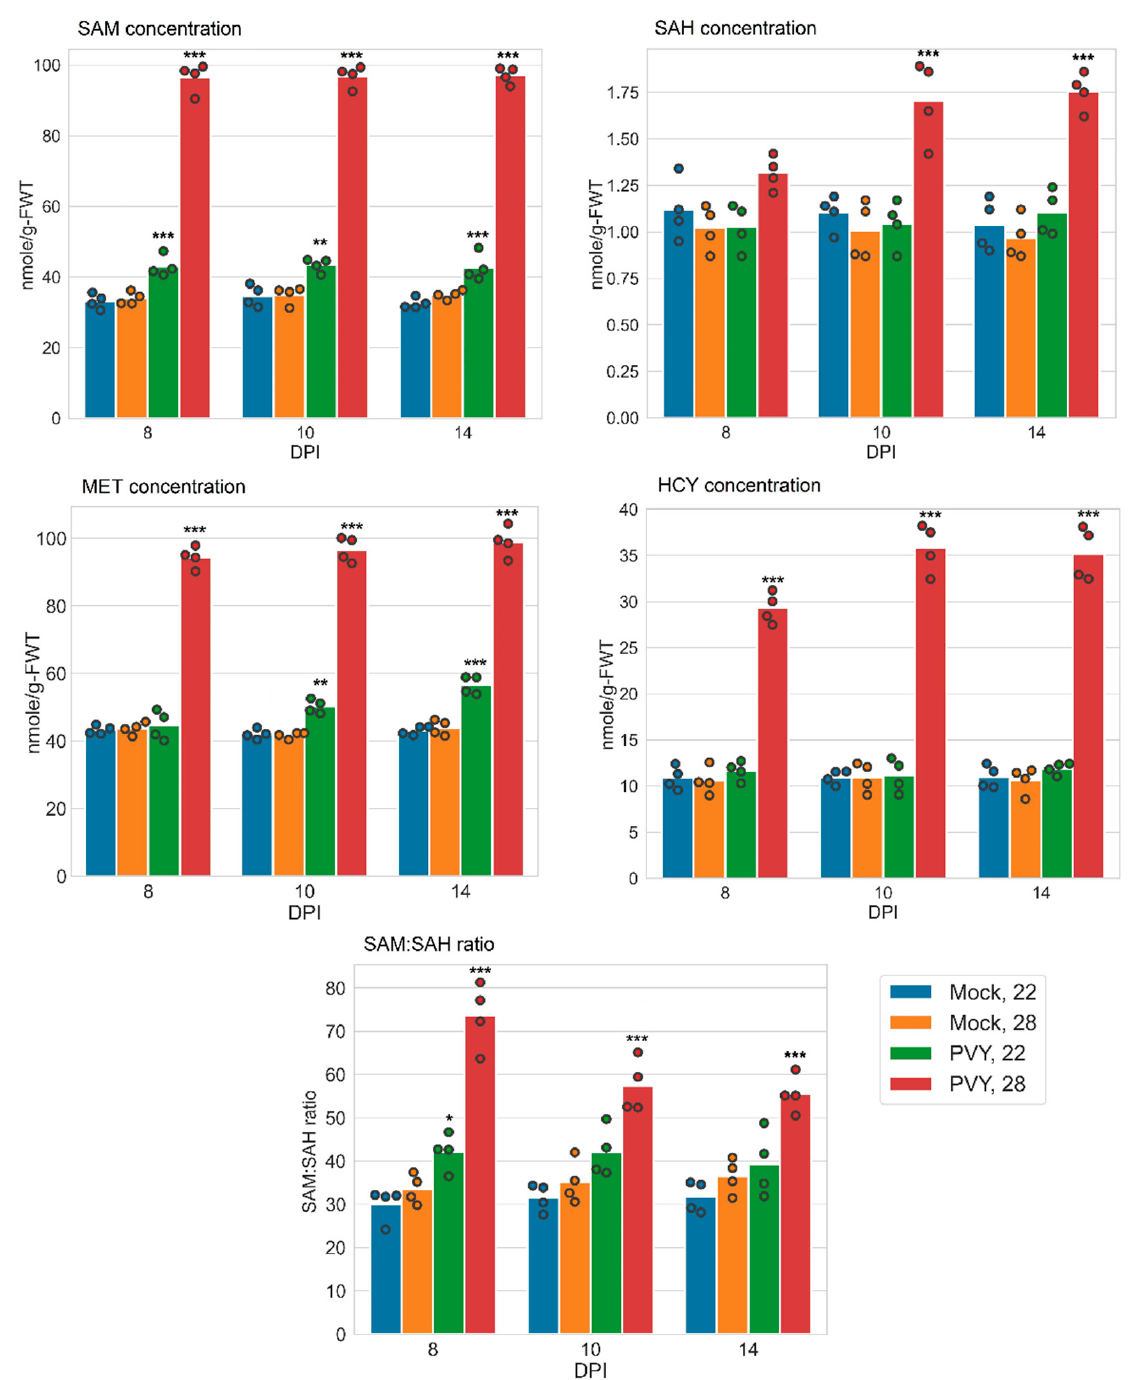
Figure 4. Content of methionine cycle (MTC) metabolites and SAM:SAH ratios in systemically infected leaves of potato plants at 22 or 28 ◦ C at 8-, 10-, and 14-days post-inoculation (dpi), as shown. Content of S-adenosylmethionine (SAM), S-adenosylhomocysteine (SAH), and homocysteine (HCY) was measured by ELISA. Content of methionine (MET) was measured using a methionine assay kit (fluorometric). Analysis of variance and Tukey’s HSD post hoc tests were performed for data. * p < 0.05; ** p < 0.01; *** p < 0.001.